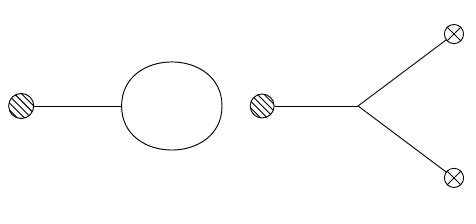
Figure 14 . Diagrams contributing to the NLO dynamical prefactor.